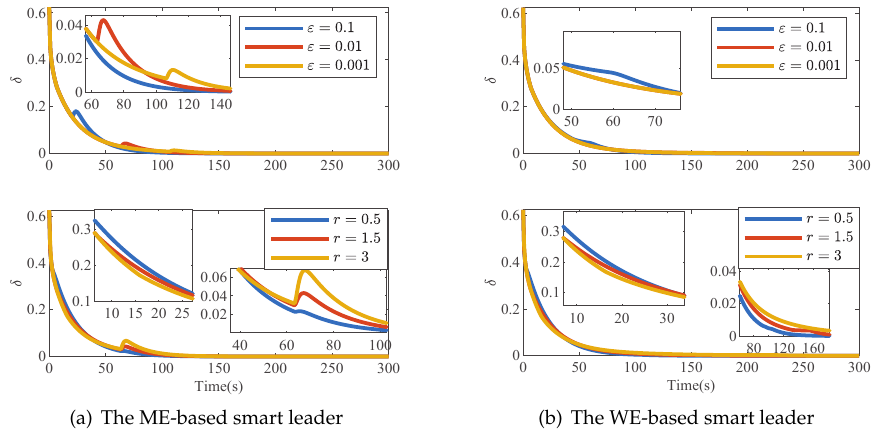
Figure 9. Influence of parameters ε and r on SoC the imbalance index of the two algorithms.